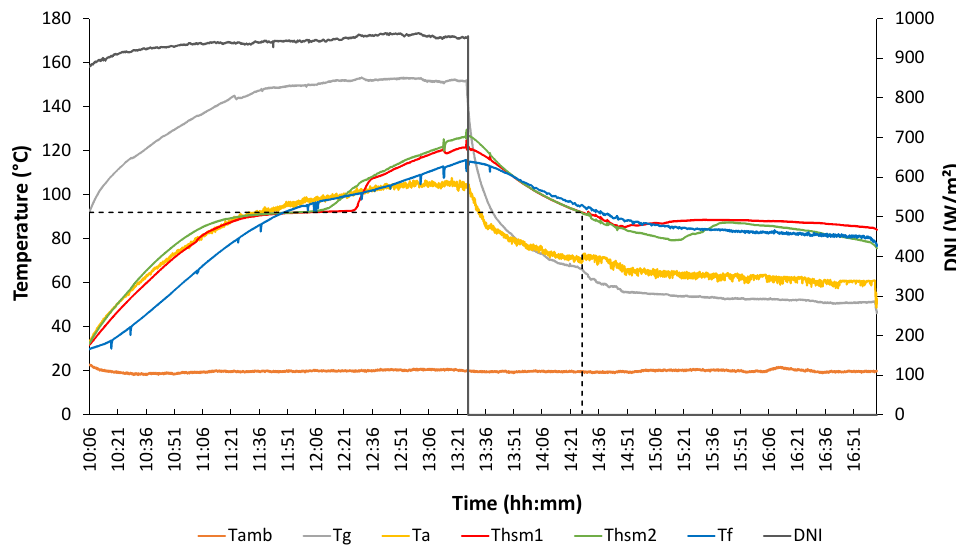
Figure 8. Results of a silicone oil + HSM test with triggering by mixing (20/05/2021, test